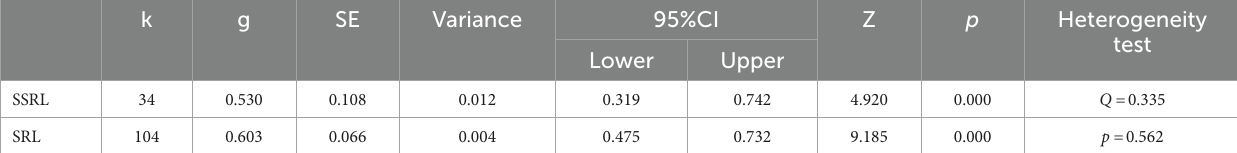
K, Number of effect sizes; g, Hedges’ g effect size; SE, standard error; CI, confidence interval. TABLE 4 Effect sizes by learning